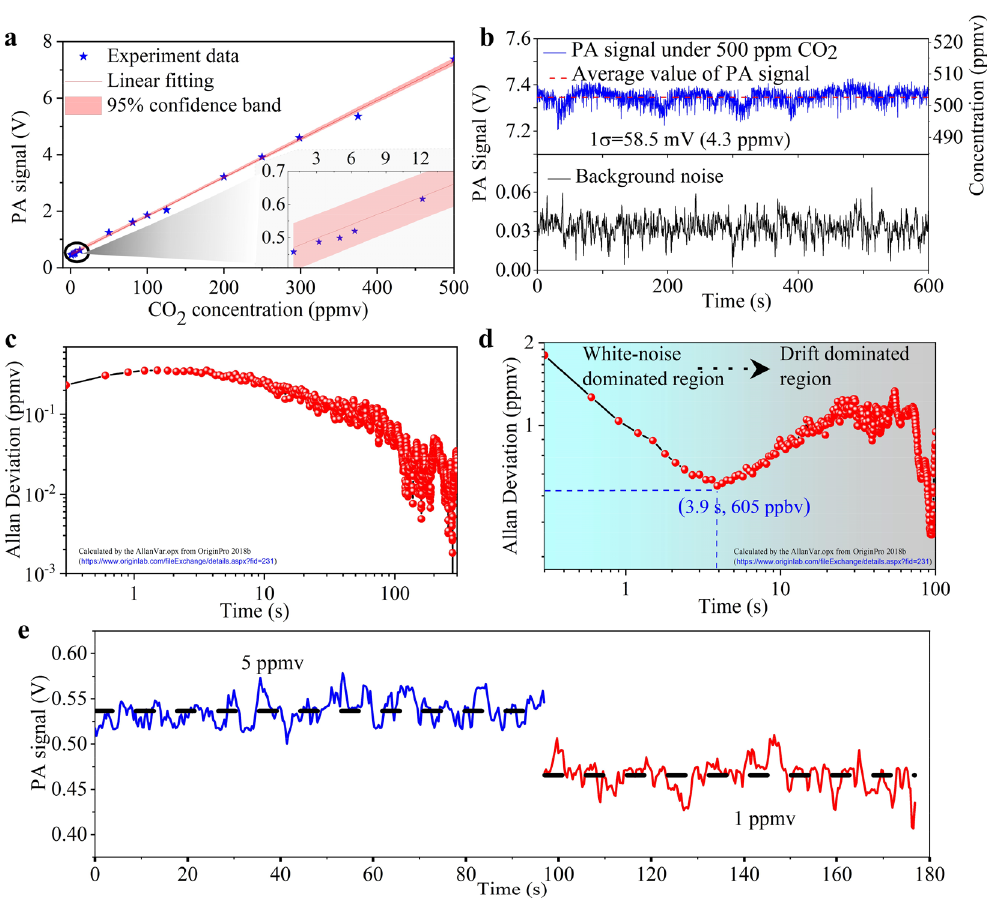
Figure 3. CO 2 monitoring results. ( a ) PA intensities measured at different CO 2 concentrations ranging from 0.5 ppmv to 500 ppmv. Inset: zoom of ( a ) with the range of 0.5 ppmv to 15 ppmv. ( b ) Top: stability measurement of the PA signal at a constant CO 2 concentration of 500 ppmv, with 3 sccm gas flow; Bottom: background noise by turning off the laser (the gas flow keeps flushed at 3 sccm). ( c ) and ( d ) are calculated Allan deviations corresponding to bottom and top curves of ( b ). ( e ) PA signals obtained at 5 ppmv and 1 ppmv CO 2